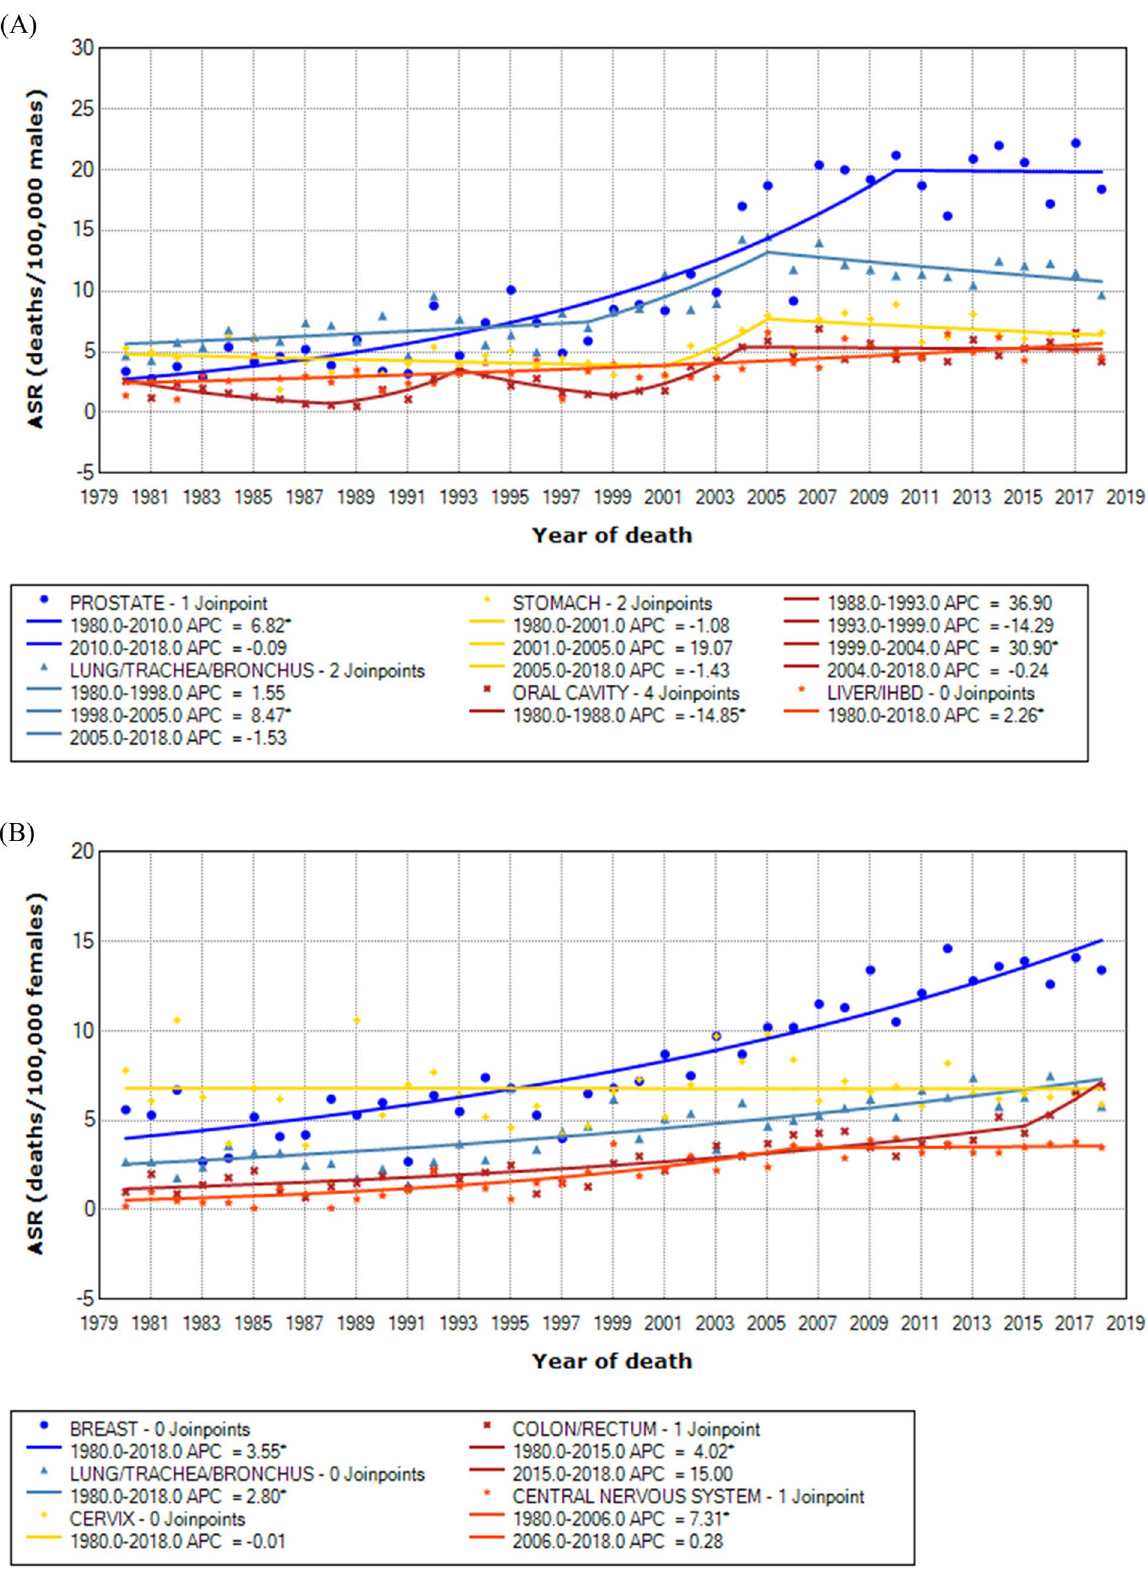
Figure 2. Time trends of cancer mortality for age-standardized rates (ASR) for the main sites in males ( A ) and females ( B